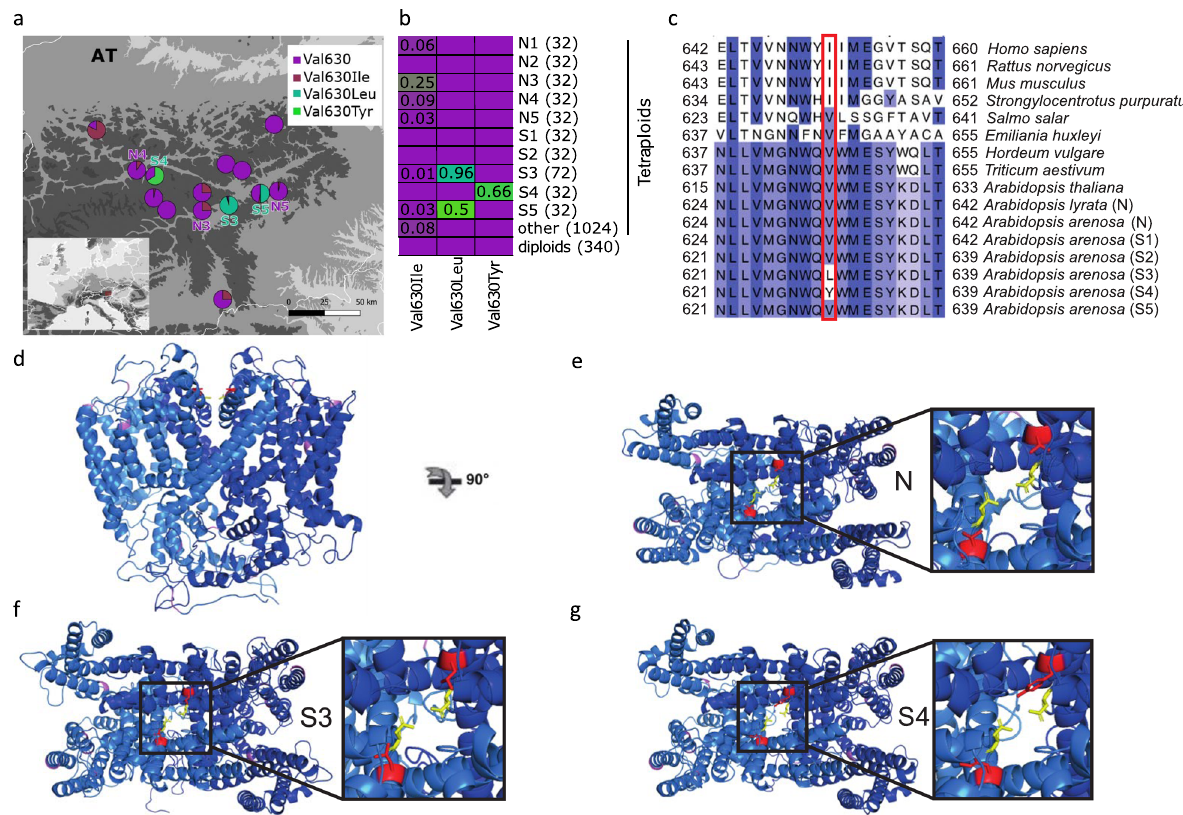
Fig. 3 Serpentine-private, convergent de novo high-impact protein changes in the TWO PORE CHANNEL 1 ( TPC1 ) locus. a All populations with serpentine-speci fi c variants and all other resequenced A. arenosa populations in the focal area of Eastern Alps, showing frequencies of amino acid substitutions at residue 630 as pie charts (map drawn by V. Kone č ná). b Population frequencies of substitutions in the residue 630 among 1,724 alleles from range-wide A. arenosa resequenced samples. Colours denote frequencies from ancestral non-serpentine (violet) to serpentine-speci fi c alleles (green) and number in brackets denotes total N of alleles screened. c Cross-kingdom conservation of the site shown by multiple sequence alignment of surrounding exon, including consensus sequences (AF > 0.5) from all serpentine A. arenosa populations (in S5 population, the frequency of Val630Leu is 0.5). Residues are coloured according to the percentage that matches the consensus sequence from 100% (dark blue) to 0% (white), the position of the serpentine- speci fi c high-frequency non-synonymous polymorphism is highlighted in red. d – g Structural homology models of A. arenosa TPC1 alleles. Dimeric subunits are coloured blue or marine. Non-synonymous variation that is not linked to serpentine soil is coloured deep purple. Residue 630 is coloured red and drawn as sticks. The adjacent residue, 627 (631 in A. thaliana ), which has an experimentally demonstrated key role in selectivity control, is yellow and drawn as sticks. d Side view of the non-serpentine allele. e Top view of the non-serpentine allele with the detail of the pore opening depicted in the inset. f Top view of the Leu630 allele private for S3 and S5 populations. g Top view of the Tyr630 allele private for S4 population. Source data underlying Fig. 3a, b are provided as a Source data fi